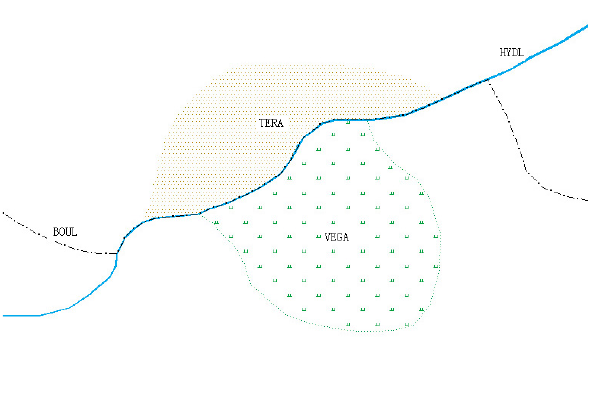
Figure 3: Public side of